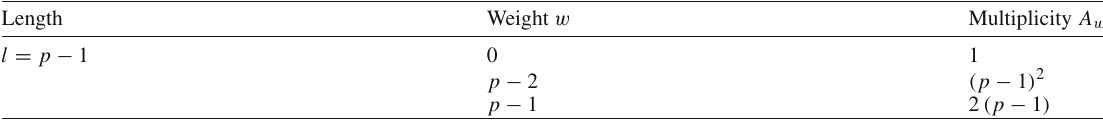
Table 2 The weight distribution of the codes given in Theorem 2.2 for β ( p ) = 1 Length Weight w Multiplicity A w